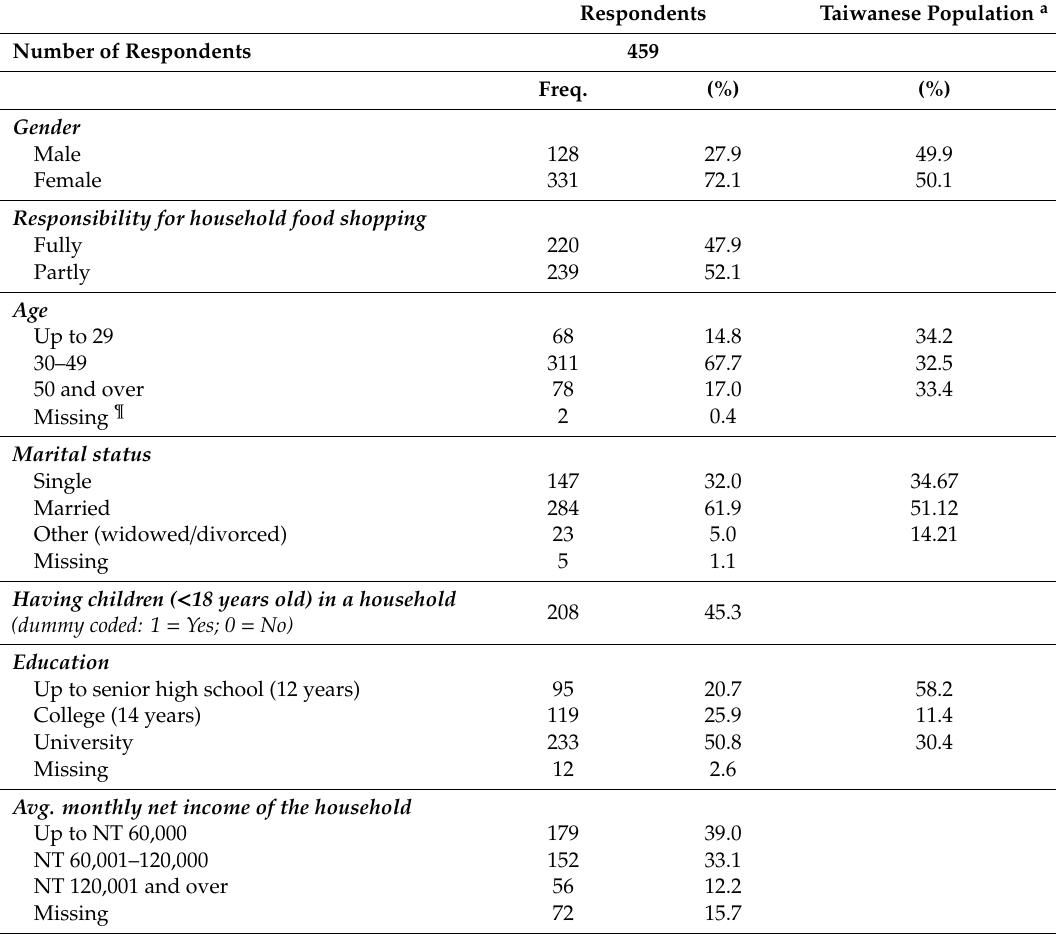
Table 3. Demographical statistics of the